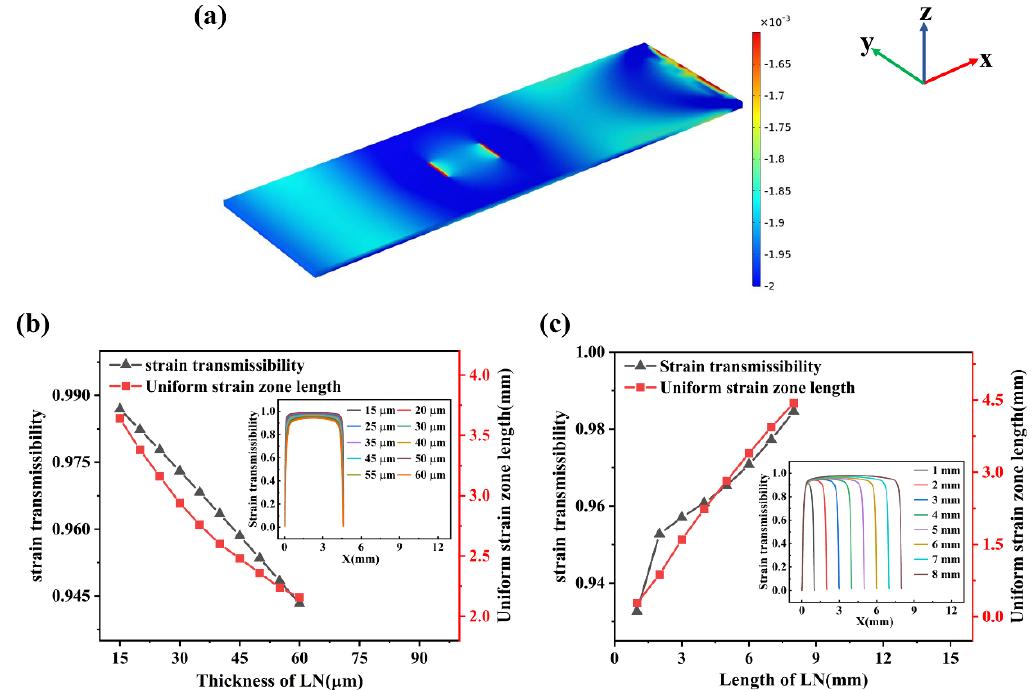
Figure 9. ( a ) The distribution cloud map of the strain tensor component S 11 ; curves of strain transfer rate and uniform strain region length as a function of LN thickness ( b ) and LN length ( c ) where the inset shows the strain transmissibility on the upper surface of the piezoelectric substrate in X-direc- tion.